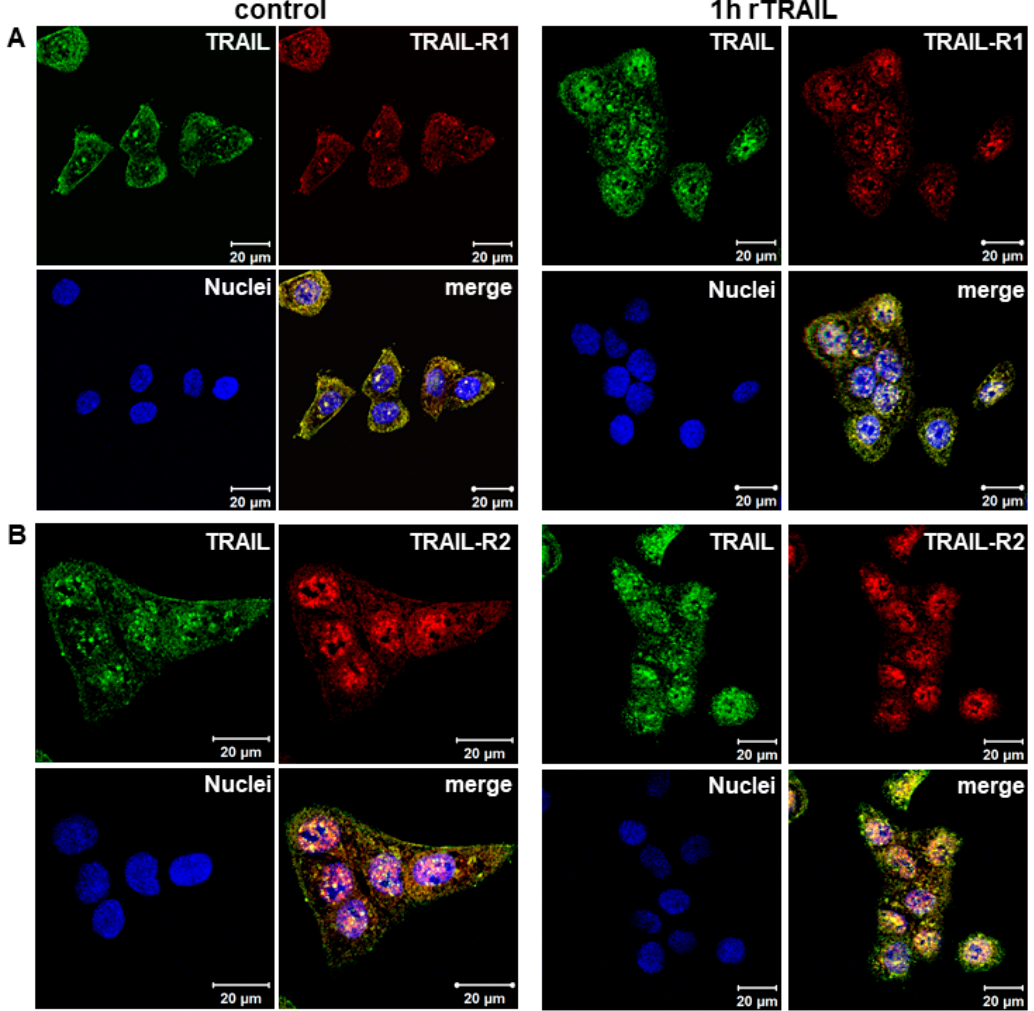
Figure 3. Constitutive and induced nuclear translocation of TRAIL-R1 and TRAIL-R2 ( A , B ) Co-localization of TRAIL-R1 and TRAIL-R2 with TRAIL was analyzed by indirect immunofluorescence and confocal LSM in Panc89 cells with or without TRAIL stimulation.